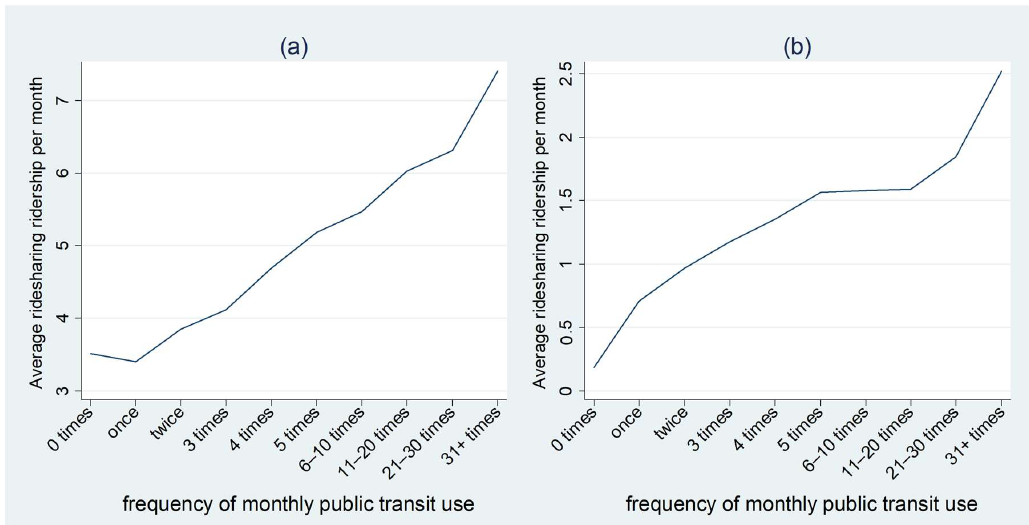
Figure 2. Average monthly ridesharing use varying by the frequency of public transit use. ( a ) includes only those who use ridesharing 1 + times in the past 30 days; ( b ) includes all the people in the sample.